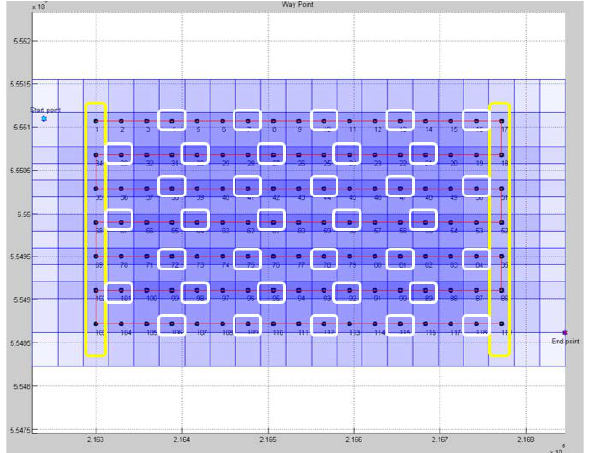
Figure 5. An example of a flight